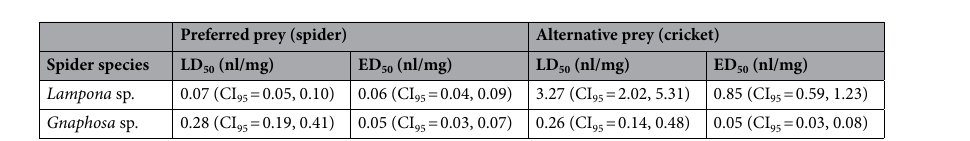
Table 1. Median lethal (LD 50 ) and median effective (ED 50 ) doses of crude venoms on two prey types. Numbers in brackets indicate 95% confidence intervals. Lethal doses were estimated from the mortality rates measured 24 h after injection; effective doses were calculated from the rates of affected prey 1 h after injection.